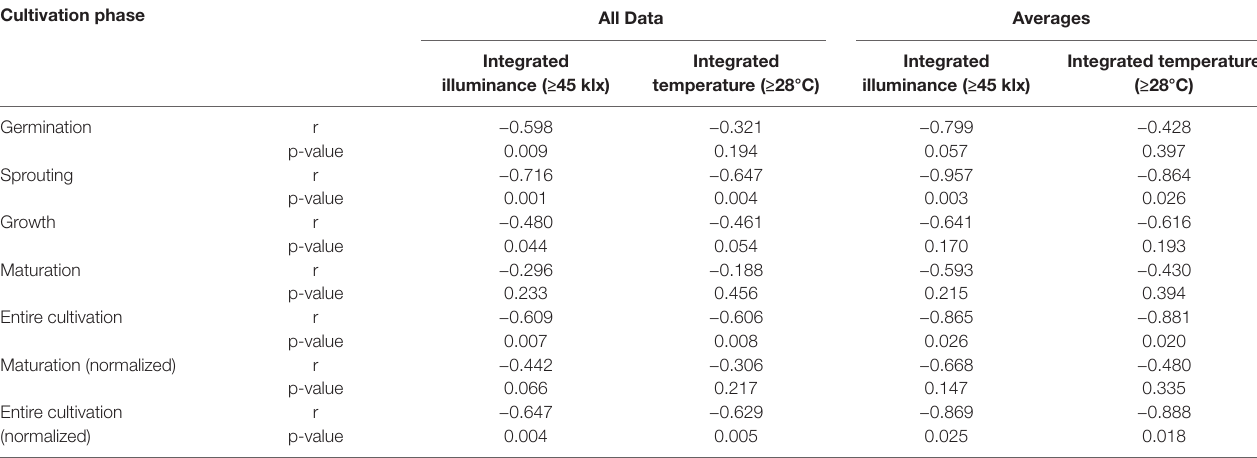
TABLE 2 | Correlation between integrated light intensity ≥45 klx or integrated temperature ≥28°C and DFE yield during different growth phases. Average values have been normalized for the duration of the interval between phases. Cultivation